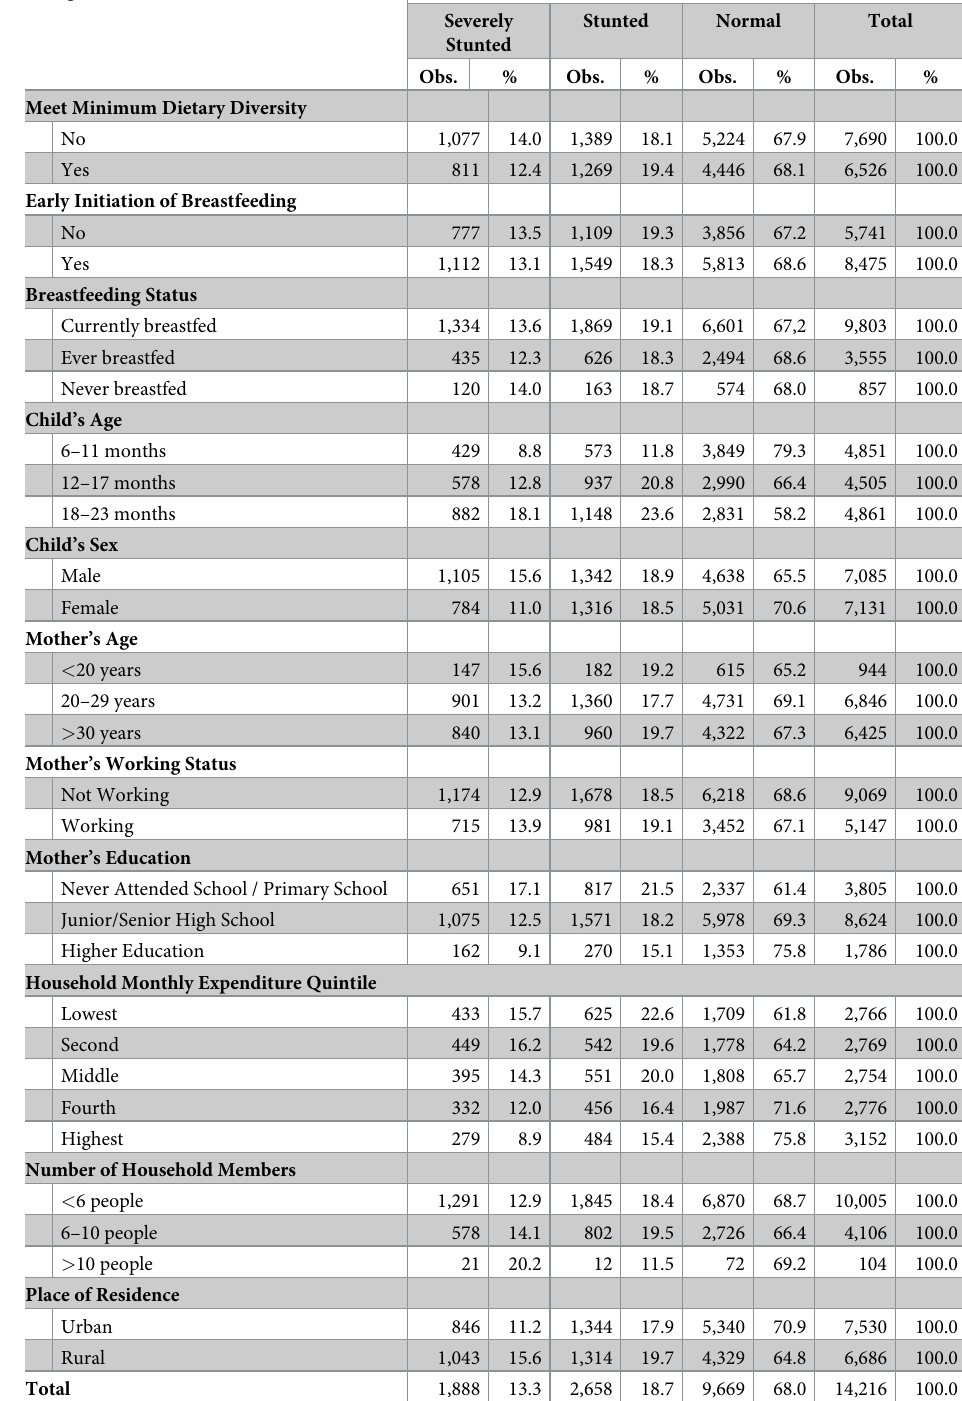
Table 3. Percentage distribution of nutritional status of infants and children aged 6–23 months by background characteristics, RISKESDAS 2018. Background